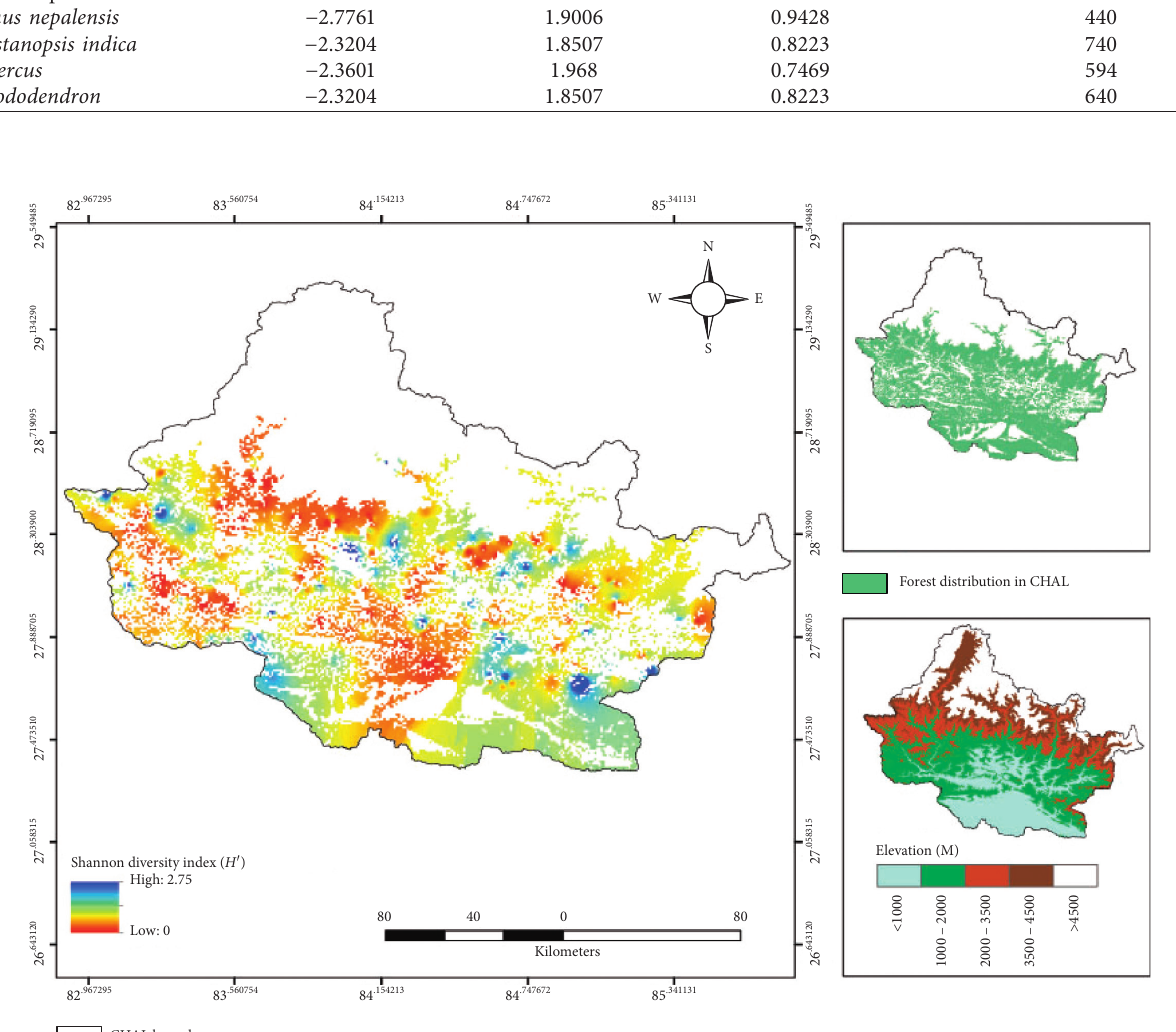
Figure 2: Tree species richness (Shannon diversity index ( H ')) distribution in